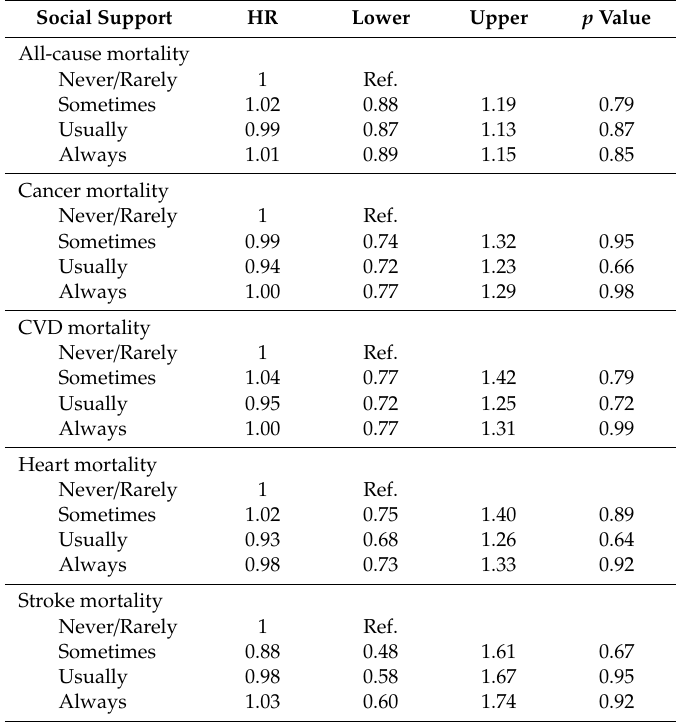
Table 4. Hazard ratios for all-cause, cardiovascular, and cause-specific mortality by received social